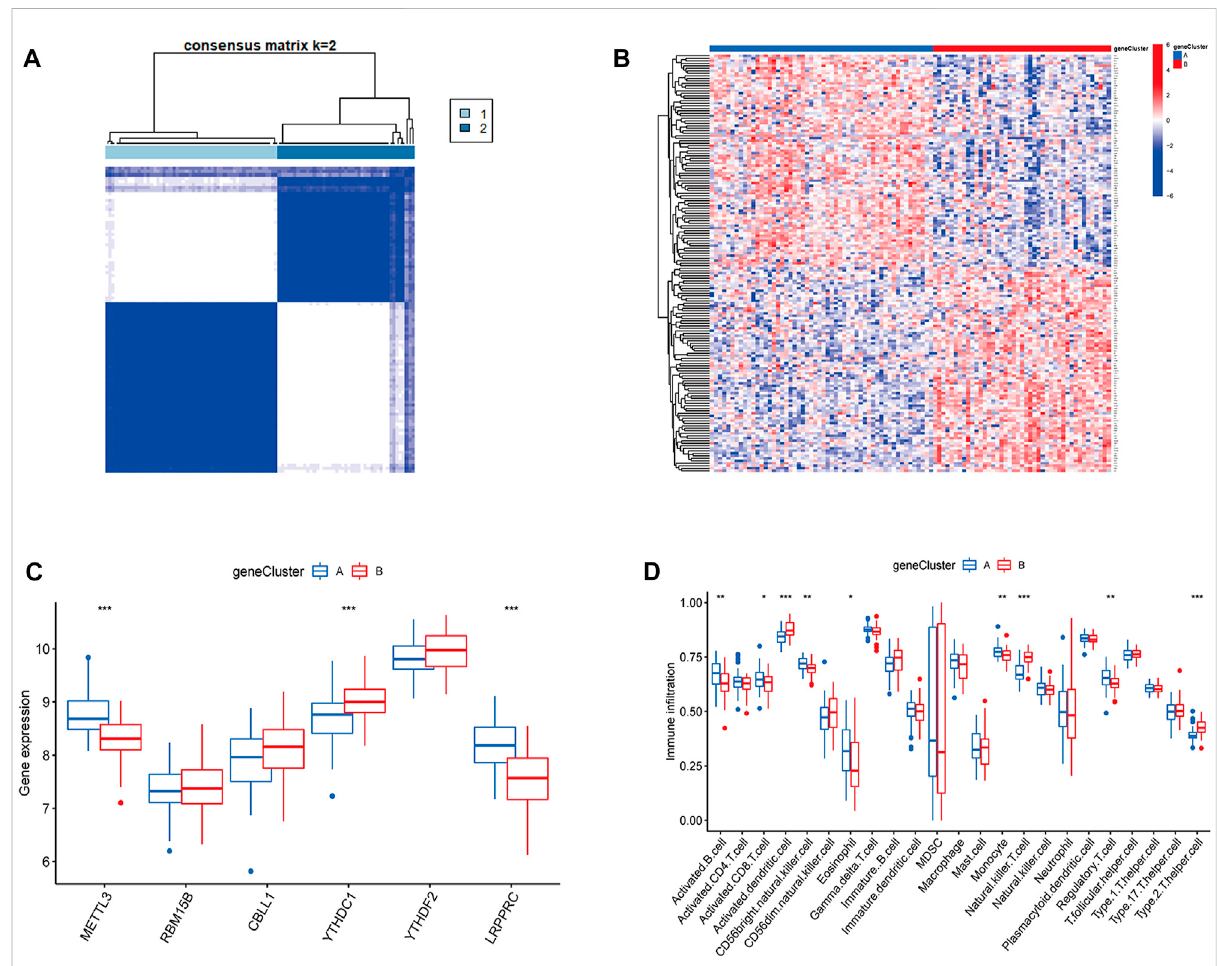
FIGURE 7 Molecularsubgroupsandimmunecellsin fi ltrationanalysisbasedonm6A-associatedDEGs. (A) Clusteredheatmapof2clusters(k=2)basedon m6A-associatedDEGs. (B) Heatmapoftypingfor167DEGs. (C) Boxdiagramofm6Aregulatorsbetweenthetwogenesubgroups. (D) Boxdiagramof immunocyte abundance between the two gene